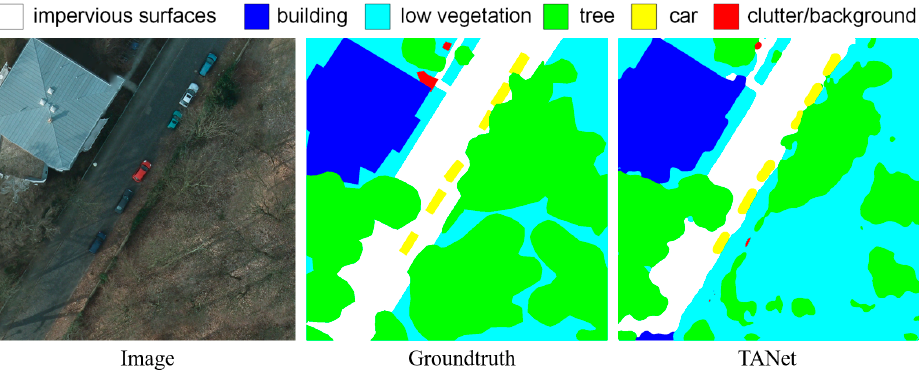
Figure 6. The features of the trees in the red rectangular area are similar to those of low vegetation, and TANet misjudged the area as low vegetation. and TANet misjudged the area as low